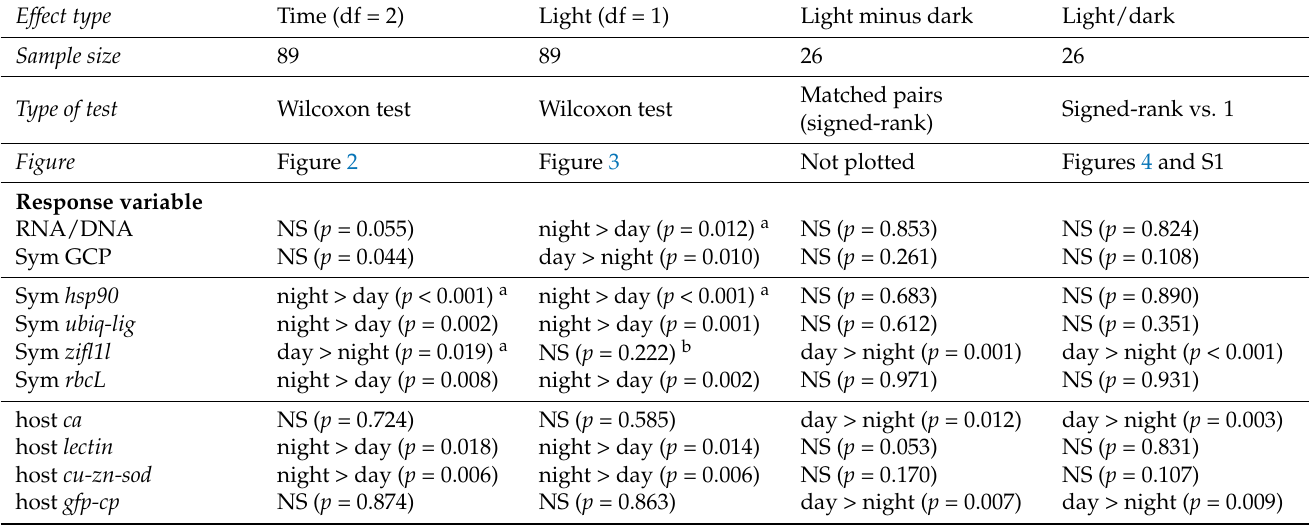
Table 3. Effects of light and time on coral response variables (RV). Rank-based tests were used for all RV due to lack of normality. When considering the entire dataset (n = 59 light vs. 30 dark), time was tested as three bins (“Time (df = 2):” morning, afternoon, or night), with light as two (“Light (df = 1):” PAR = 0 vs. >0 µ mol/photons m 2 /s). When analyzing only the 26 colonies that were sampled twice (approximately solar noon and 1-hr post-sunset), both non-parametric matched-pairs tests (i.e., signed-rank of “Light minus dark”), or one-sample signed-rank tests of the mean “Light/dark” ratio against a null hypothesis of 1 were instead undertaken. Sample sizes for the three southern